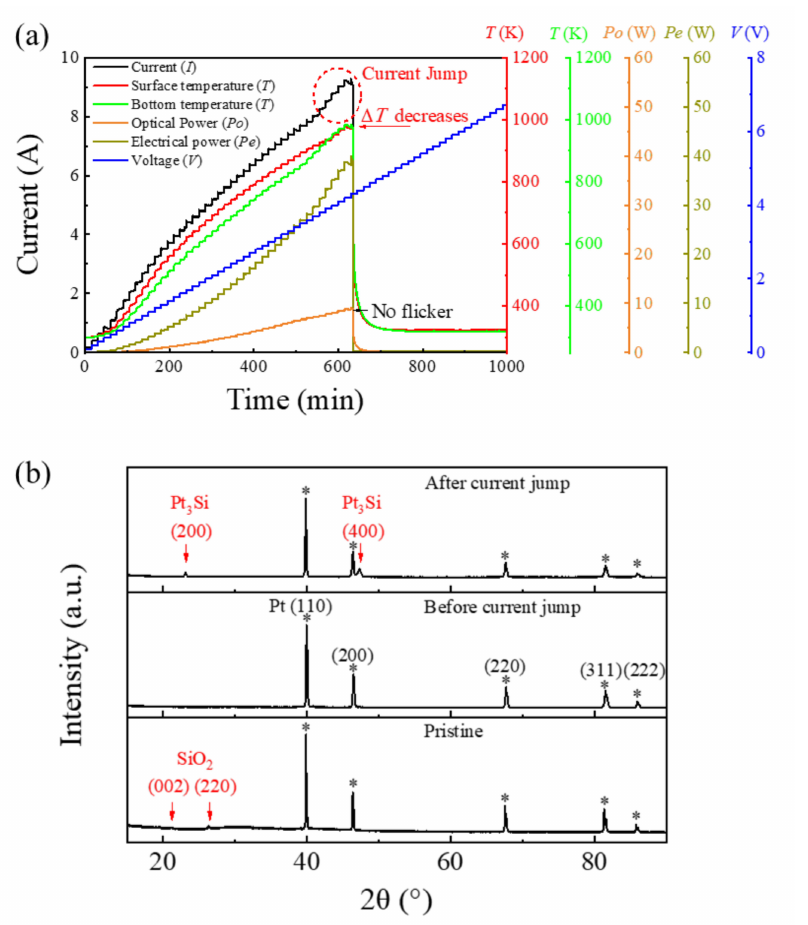
Figure 8. ( a ) The failure test of the platinum (Pt) electric heating film used in an LMM emitter. ( b ) The X-ray diffraction patterns of the Pt films in a pristine state, as well as before and after the current jump. (The * stands for diffraction peaks originated from Pt